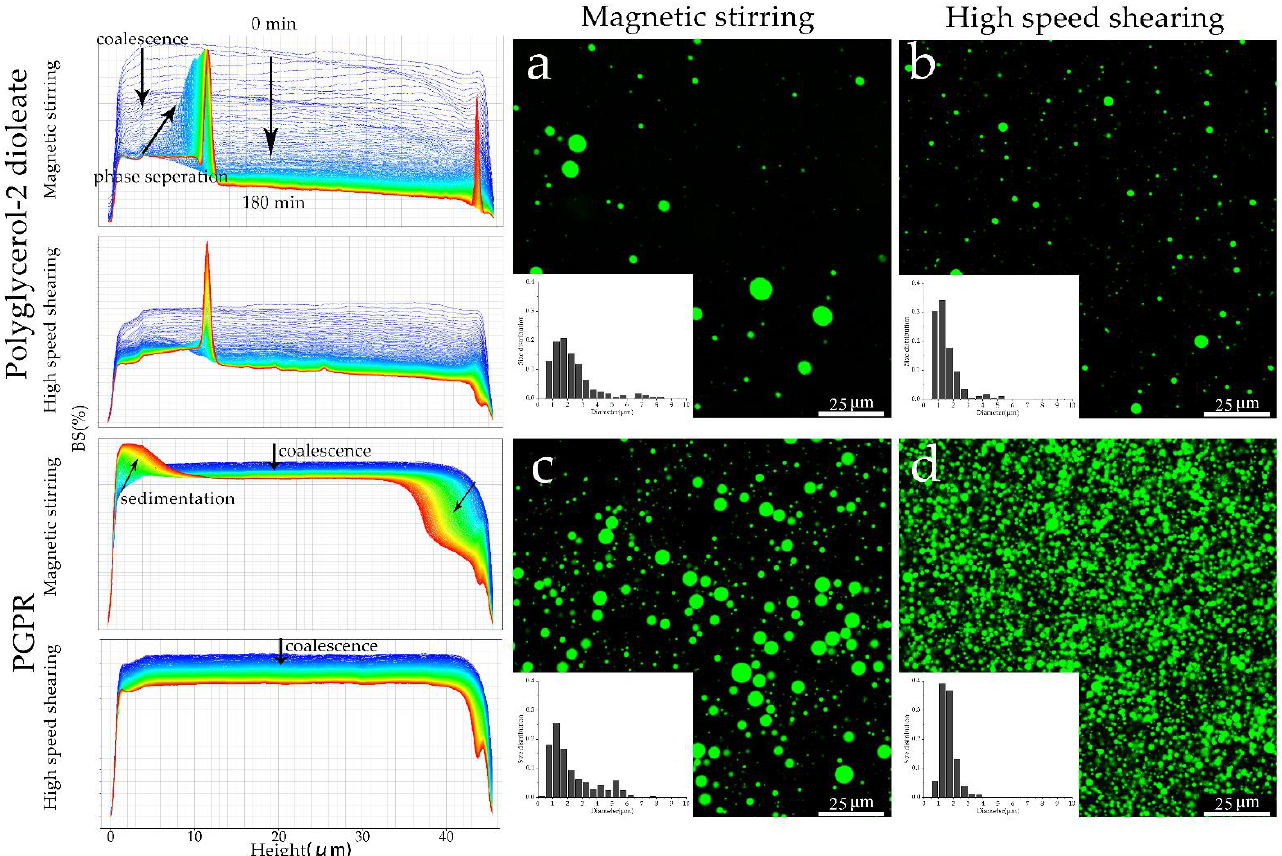
Figure 6. Changes of emulsion stability during preparation and storage ( left ); CLSM images of fresh prepared emulsions, a-d corresponding to the emulsions prepared by magnetic stirring and high speed shearing using polyglycerol-2 dioleate and PGPR as emulsifier respectively ( right ).